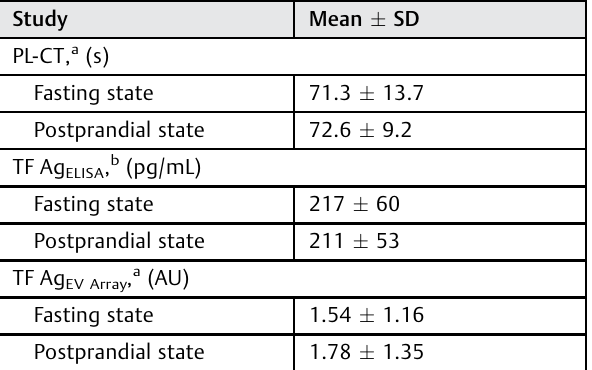
Table 2 Biological variation in procoagulant phospholipid – dependent clotting time (PPL-CT) and tissue factor antigen